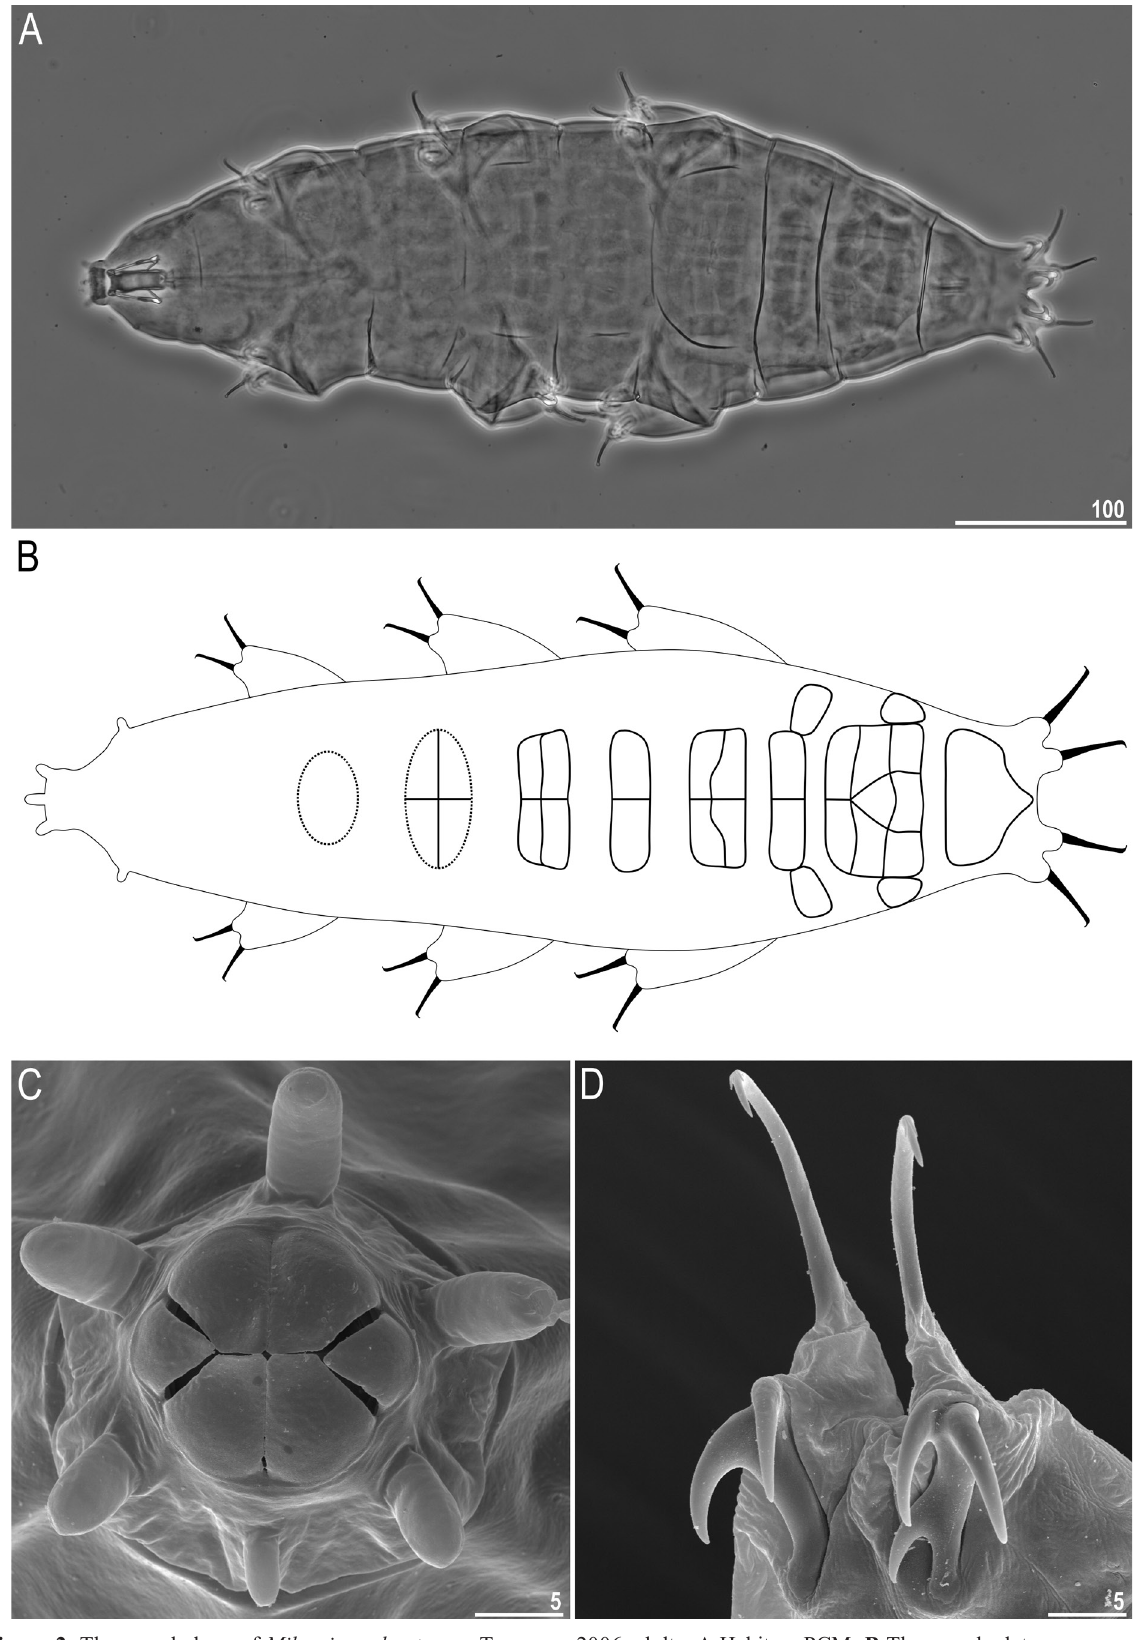
Figure 2. The morphology of Milnesium almatyense Tumanov, 2006 adults. A Habitus, PCM; B The pseudoplate arrangement based on adult specimens from population KZ.003, drawing; C SEM photograph of mouth opening; with six, unequal in size peribuccal lamellae, so-called 4+2 configuration; D SEM photograph of claws II with a [2-3] CC and visible accessory points. All the scale bars are given in